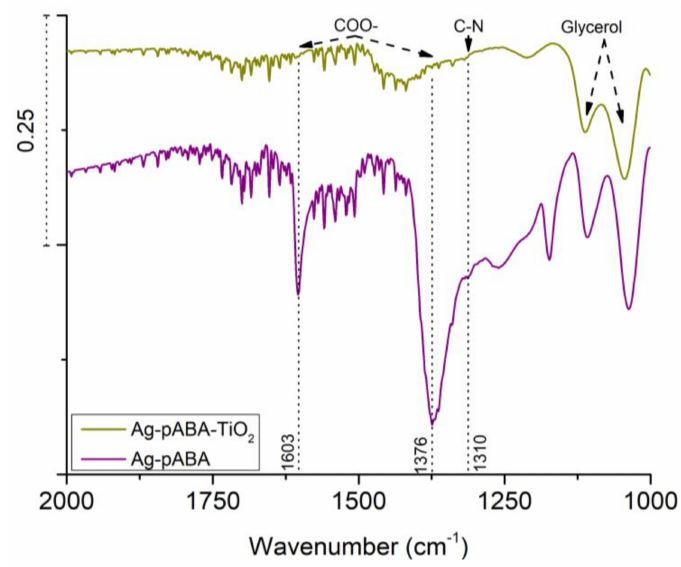
Figure 6. FTIR spectra of Ag-pABA-TiO 2 (dark yellow trace) and Ag-pABA (purple